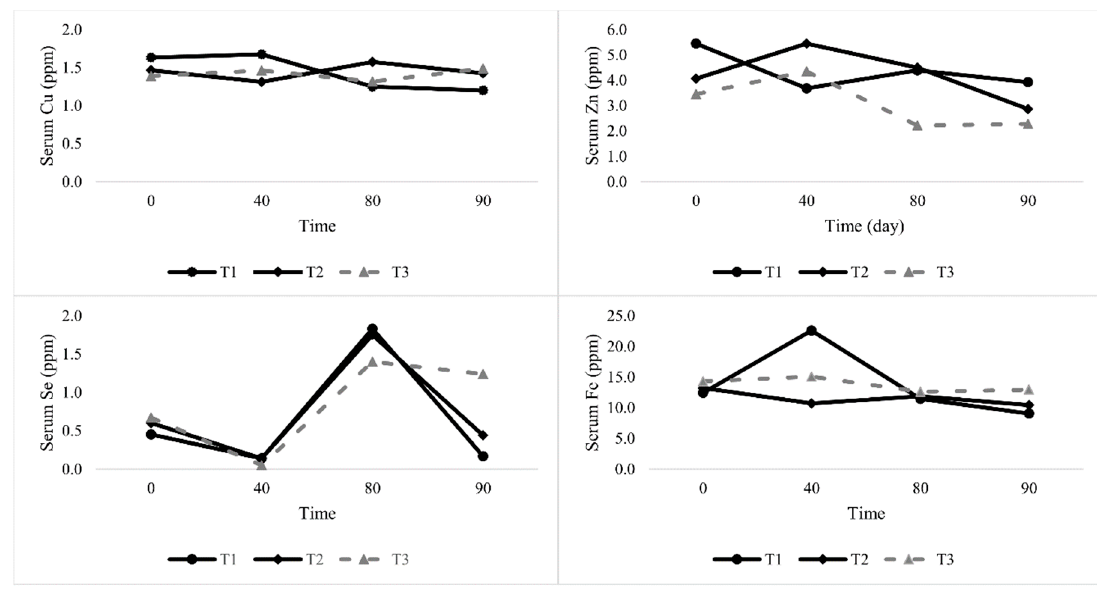
Figure 1. Effect of experimental diets on some mineral levels in the serum (ppm) of lambs at different times. T1: (75.3% PKC + 0% corn), T2: (70.3% PKC + 5% corn), and T3: (65.3% PKC + 10% corn). PKC = palm kernel cake.